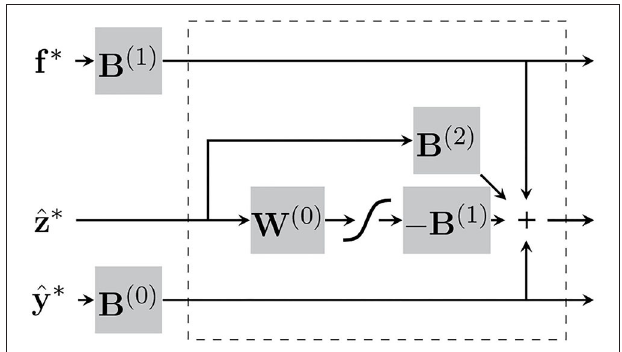
FIGURE 5 | The “encoding” step for each patch can be conceptualised as recurrent neural network, consisting of matrix-vector multiplications and a softmax. The section within the dotted-lines represents each iteration of the variational updates of the latent